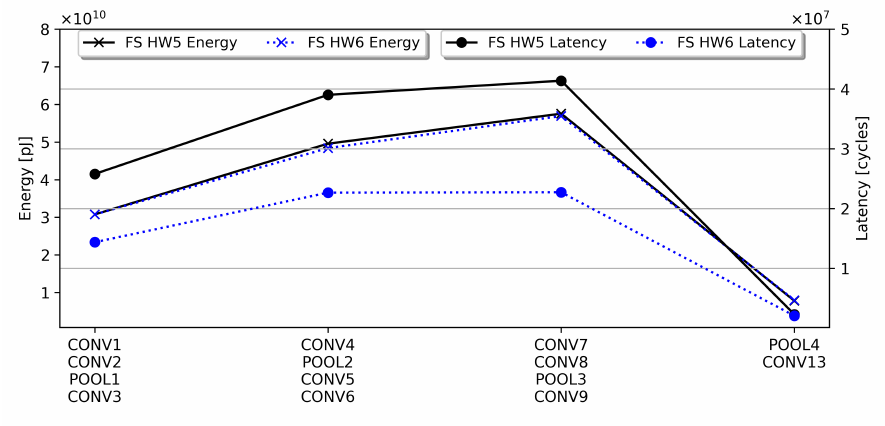
Figure 19. Energy and latency estimates for VGG16-E, mapped with temporal fusion with HW config. 3 and